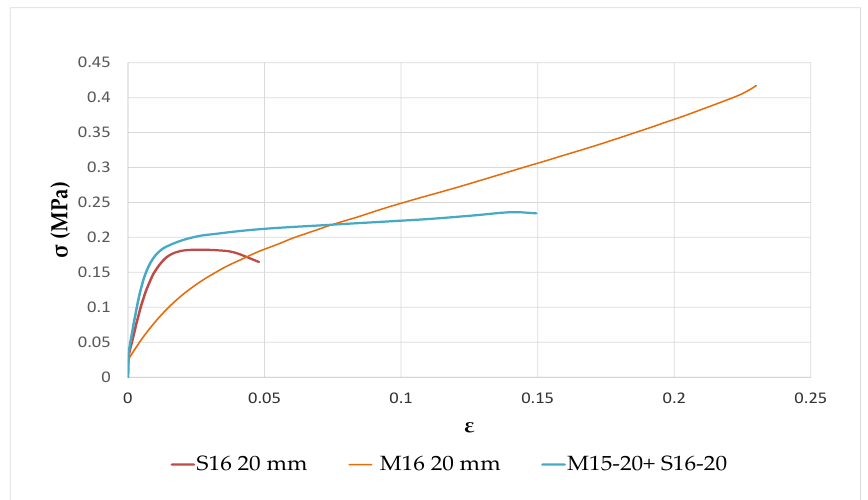
Figure 14. Comparison of the mechanical properties of rapeseed concretes made with M16, S16 straws, and a mixture of both.